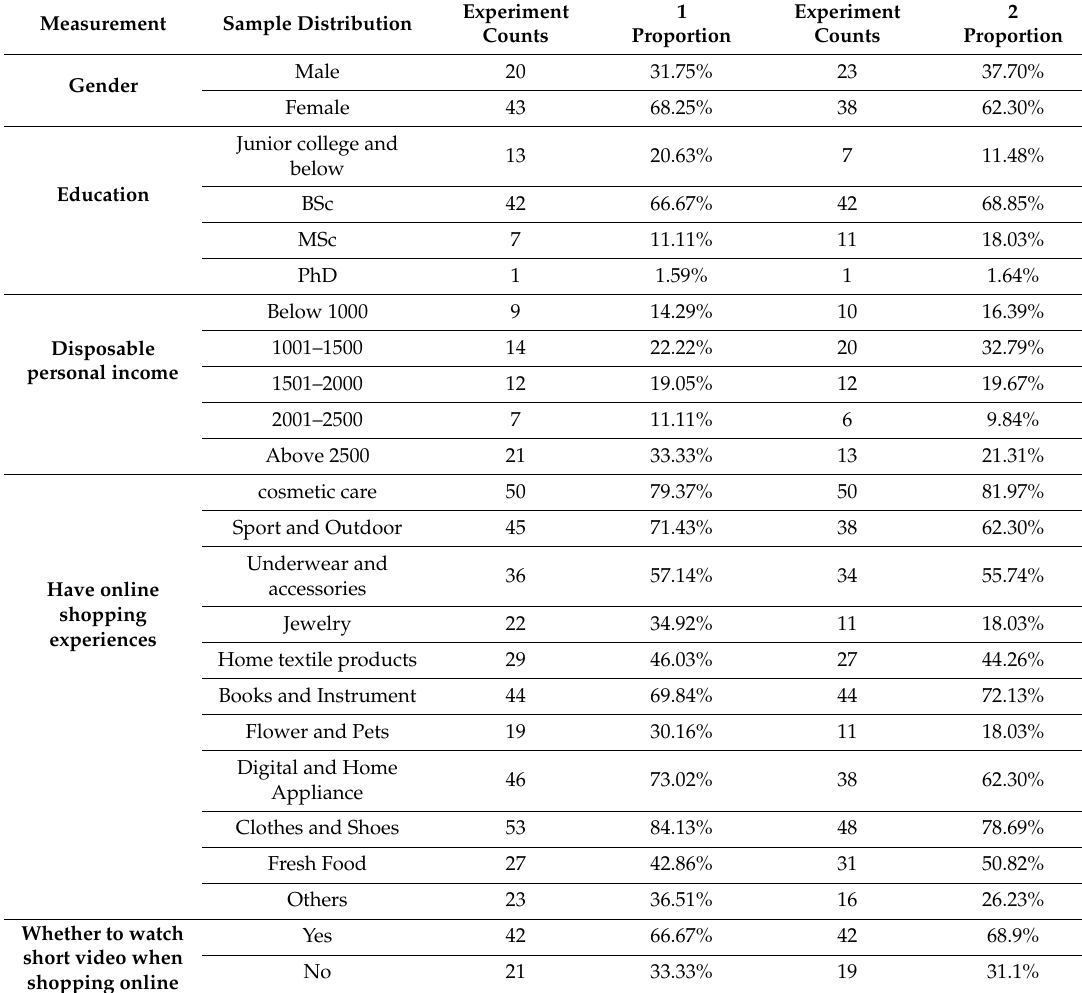
Table 3. Experiment samples’ demographic